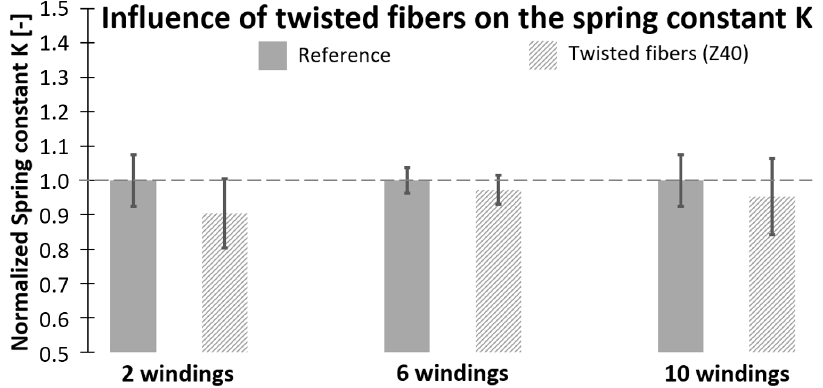
Figure 15. Spring constants measured on simple loops with (40 turns/m) and without (<5 turns/m) twisted fibers. twisted